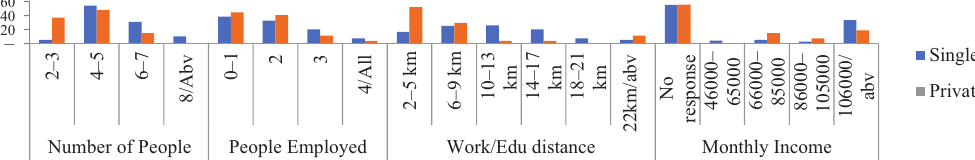
Figure 4. Employment detail of the residents of S.U. houses and apartments (source: field